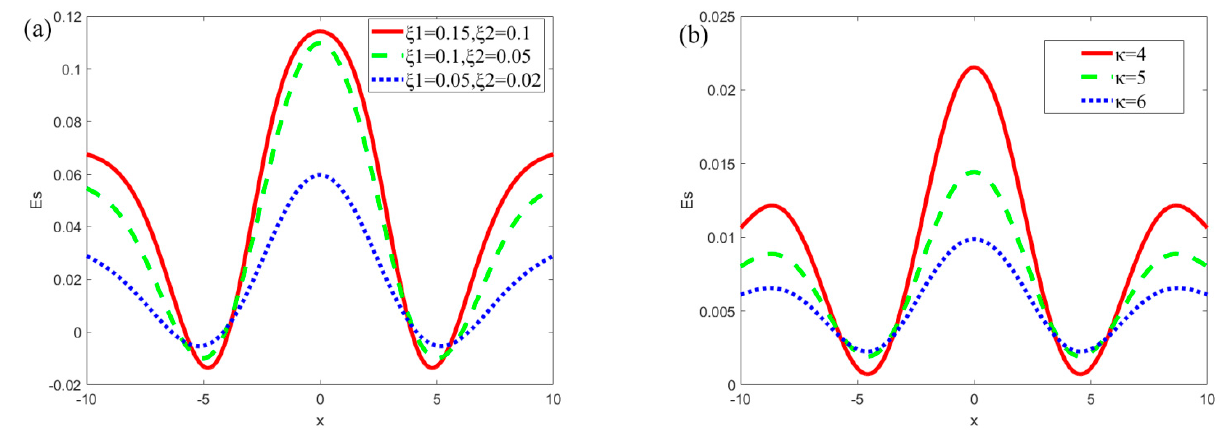
Figure 5. The variations of streaming potential E s for different ξ i ( i = 1, 2) and κ ( m = 0.5, n = 0.8, α = 5, β = 5, R = 1, δ = 0.1, Ha = 1, u r = 1). ( a ) E s at different ξ 1 and ξ 2 ( κ = 3); ( b ) E s at different κ ( ξ 1 = 0.02, ξ 2 = 0.02). ξ 2 =